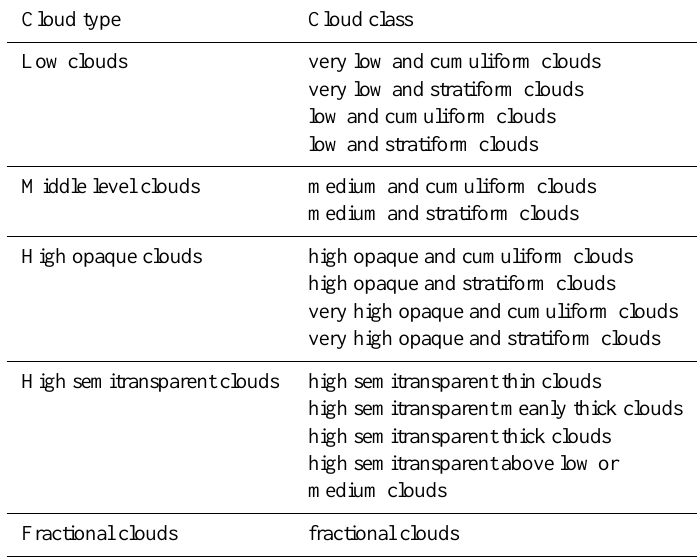
Table 2. Transfer table from sophisticated NWC SAF msgv2012 cloud classes to the general cloud types provided by CM SAF (see Der- rien